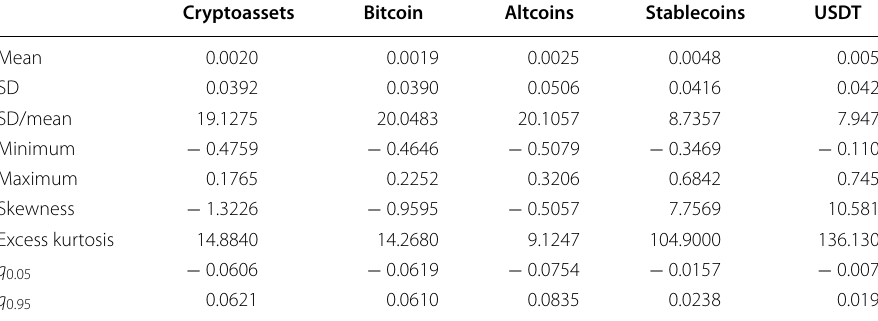
The statistics are presented for the logarithmic differences of market capitalizations. Cryptoassets represent the total market capitalization of the highly capitalized cryptocurrencies and tokens (listed in the text), not including the stablecoins. Stablecoins represent the total market capitalization of the 23 stablecoins listed in the